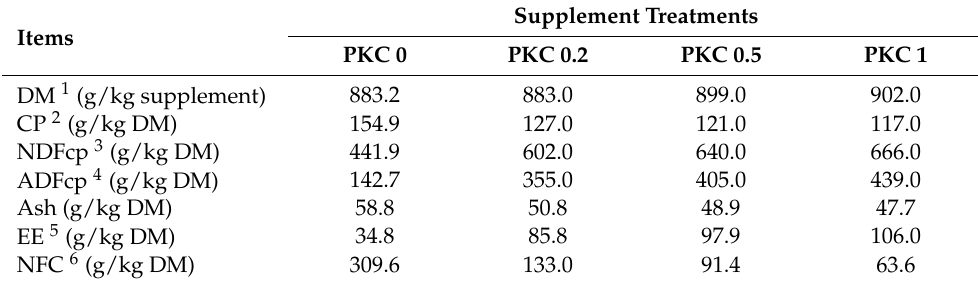
Table 2. Chemical composition of the diets with the inclusion of palm kernel cake supplement based on dry